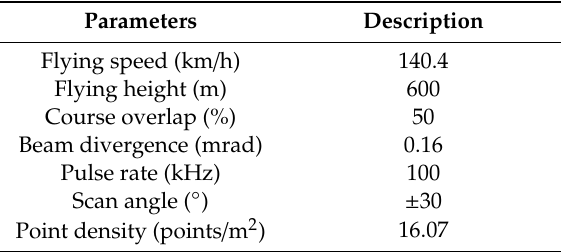
Table 2. Light detection and ranging (LiDAR) flight parameters.